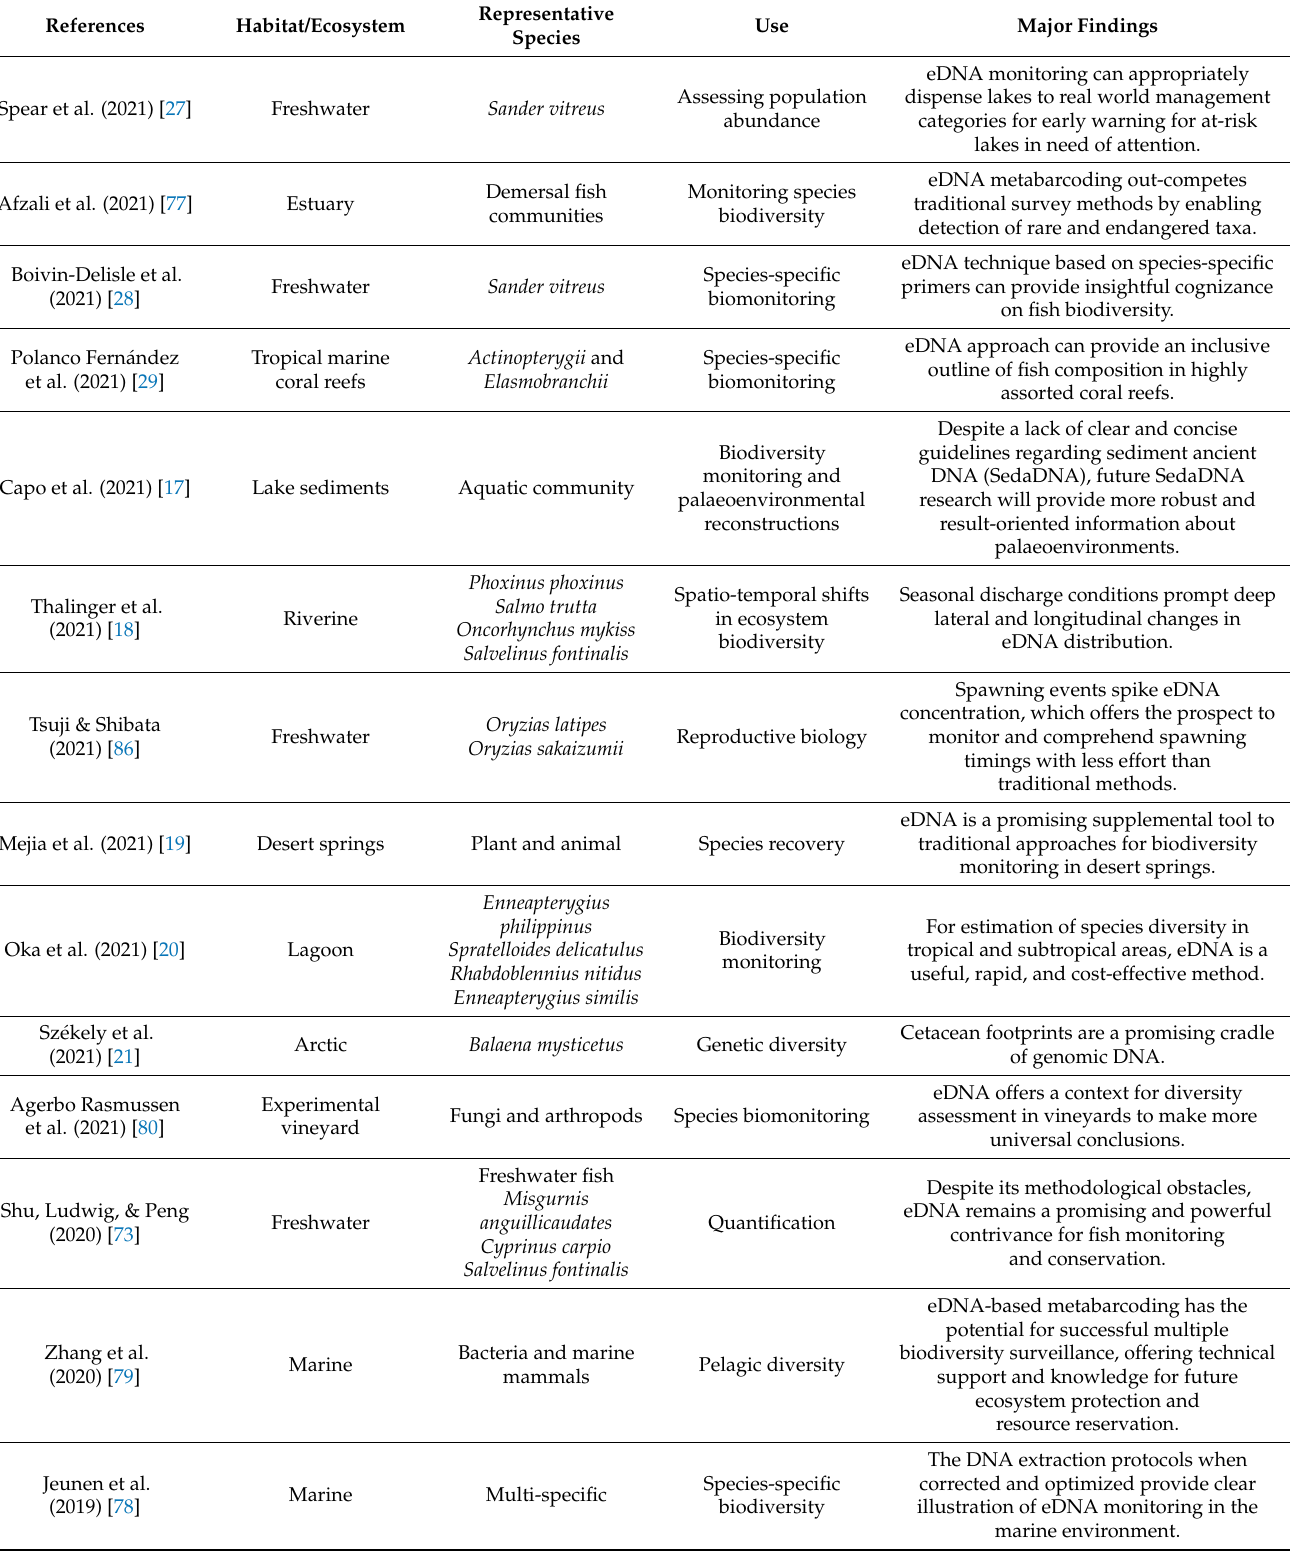
Table 2. A sample of research publications that focused on environmental DNA as a species monitor- ing